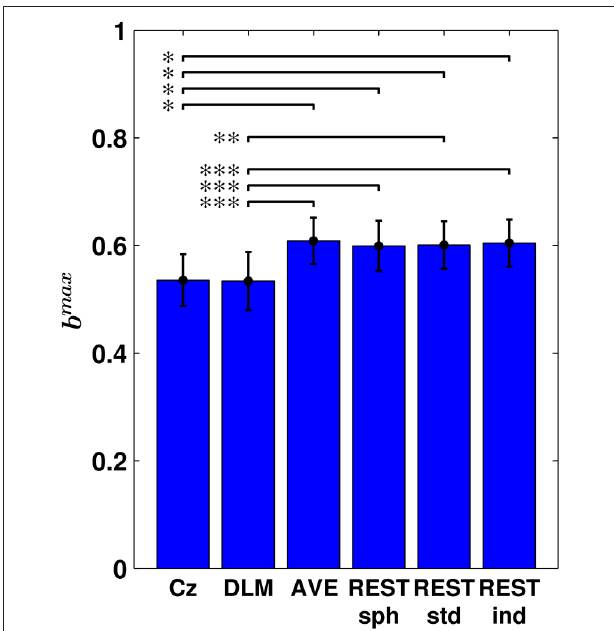
FIGURE 5 | Maximum bicoherence ( b max ) obtained for the different EEG reference schemes. The bar plot shows the average b max across subjects and its standard error. Statistical comparison between the different reference schemes was performed by using a paired sampled t -test (* p < 0.05; ** p < 0.01; *** p < 0.001; two-tailed; fdr-corrected; permutation test).